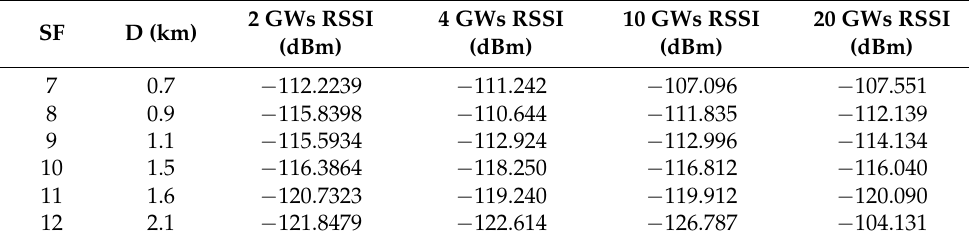
Table 5. RSSI estimation of multi-gateways.